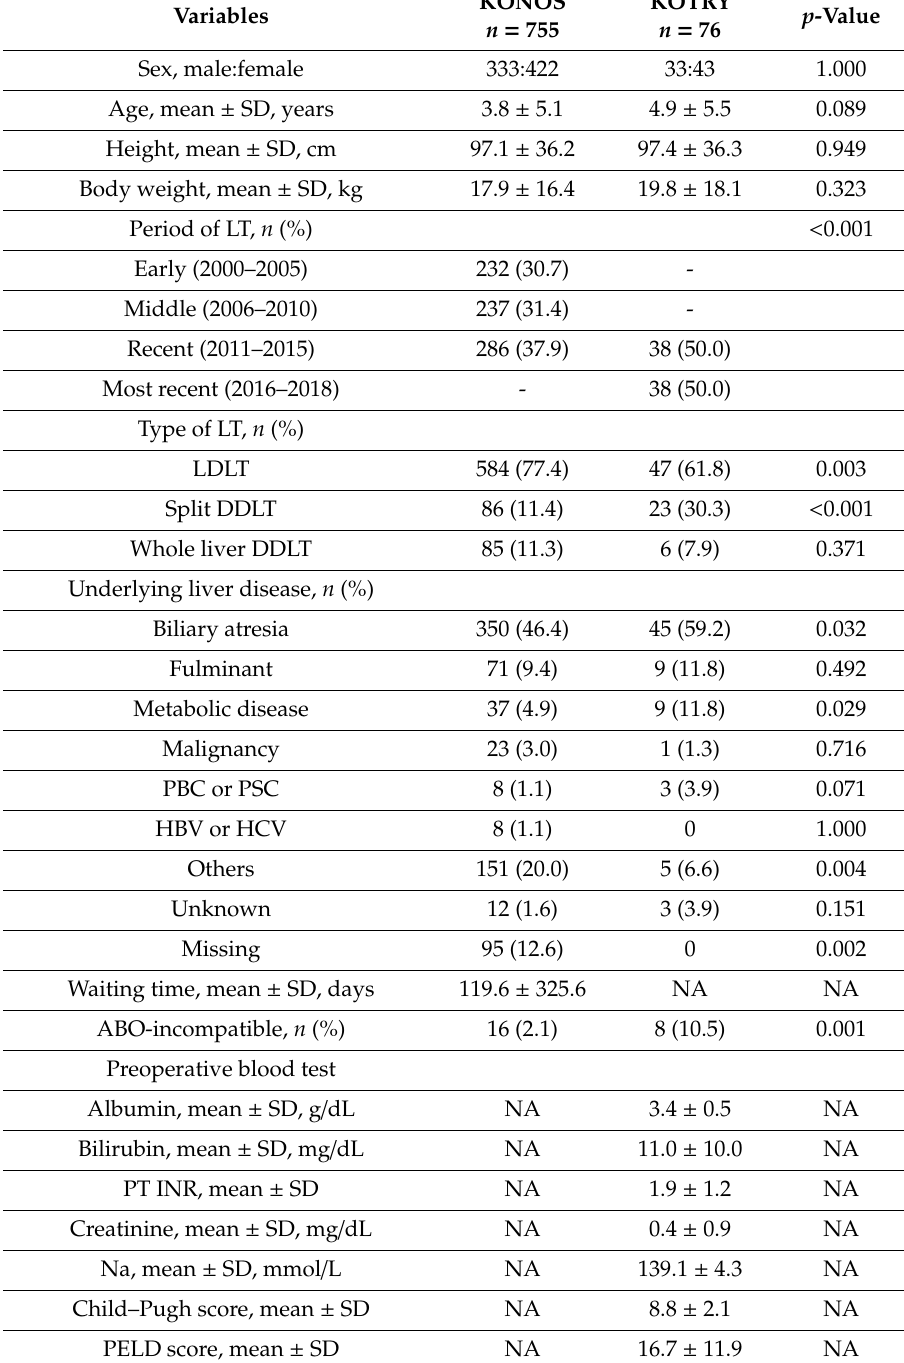
Table 1. Demographic and clinical characteristics of pediatric patients in the KONOS and KOTRY